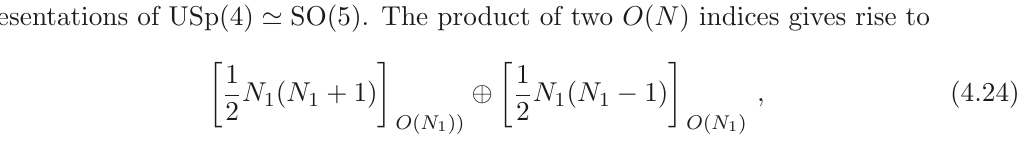
Table 4 . The spectrum of the HS primary operators in the The indices i, j label the fundamental representation of SO(5) R . The Young tableaux denotes the representation of O ( N